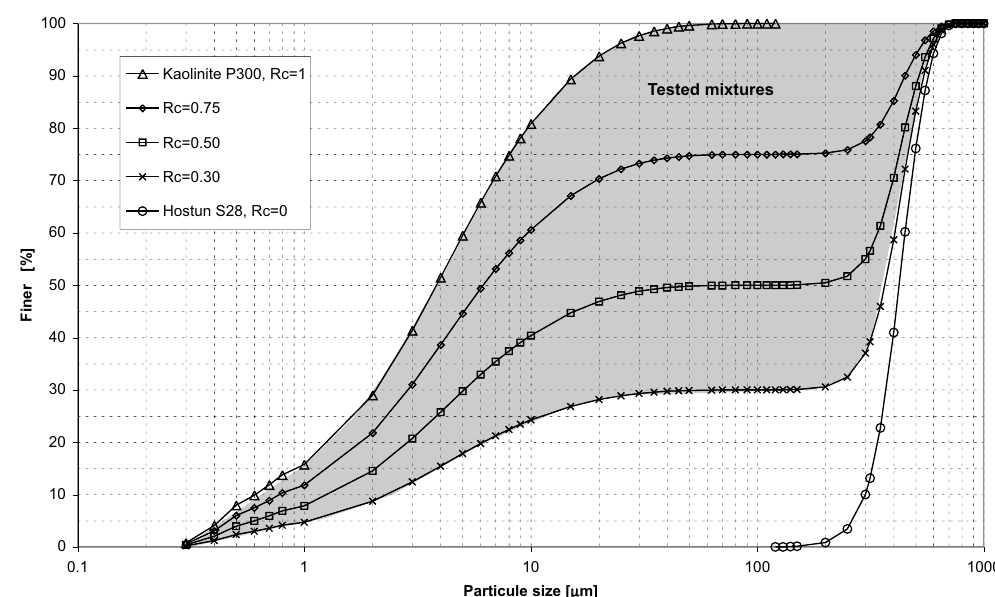
Fig. 4 – Range of variation of grain size distribution of